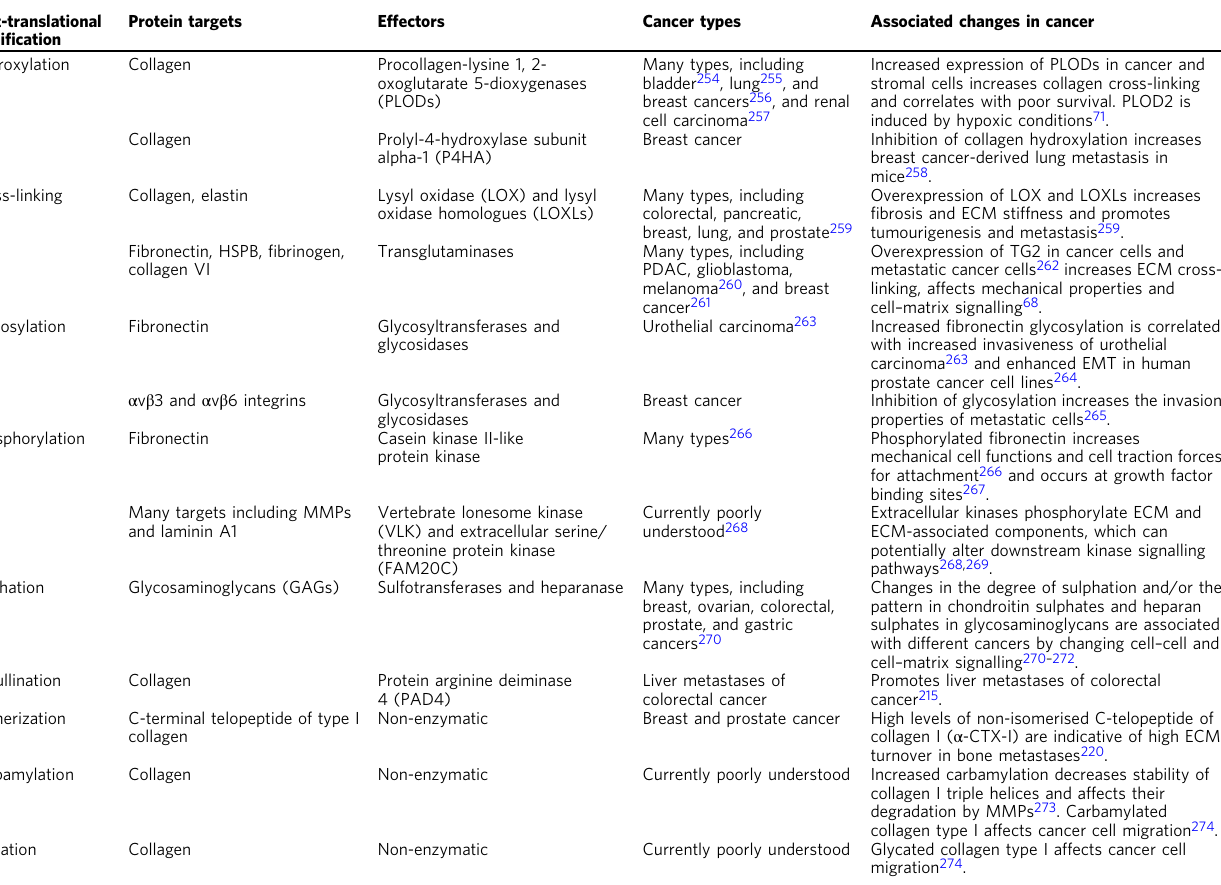
Table 1 Post-translational modi fi cations of ECM and ECM-associated molecules and their implications in